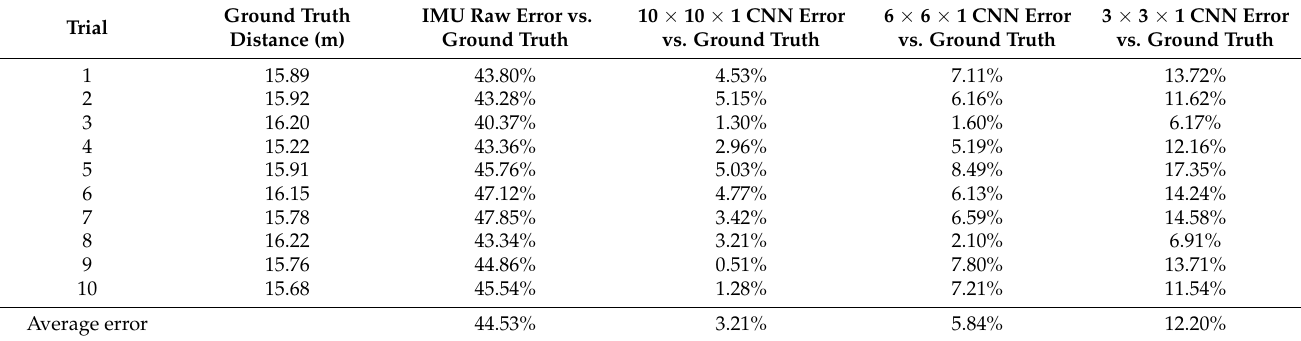
Figure 8. Two − Dimensional Train tracks drawn from TDK IMU raw data, 10 × 10 × 1, 6 × 6 × 1, and 3 × 3 × 1 CNN.